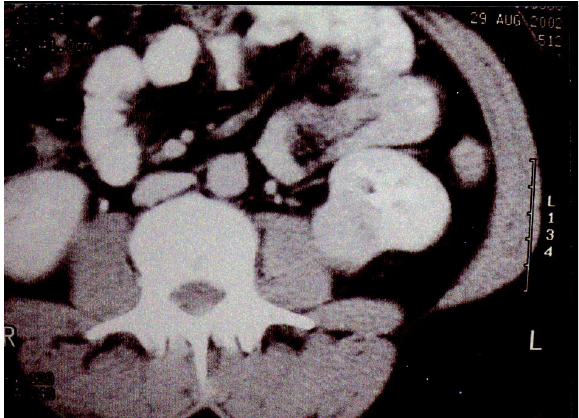
Figure 1 – Computed abdominal tomography showing a 3 x 3 cm solid mass at the lower pole of the left kidney.